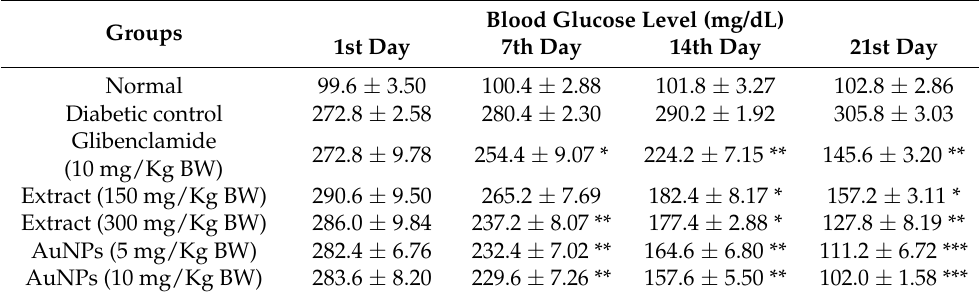
Table 9. Effect of methanol extract and AuNPs on blood glucose.